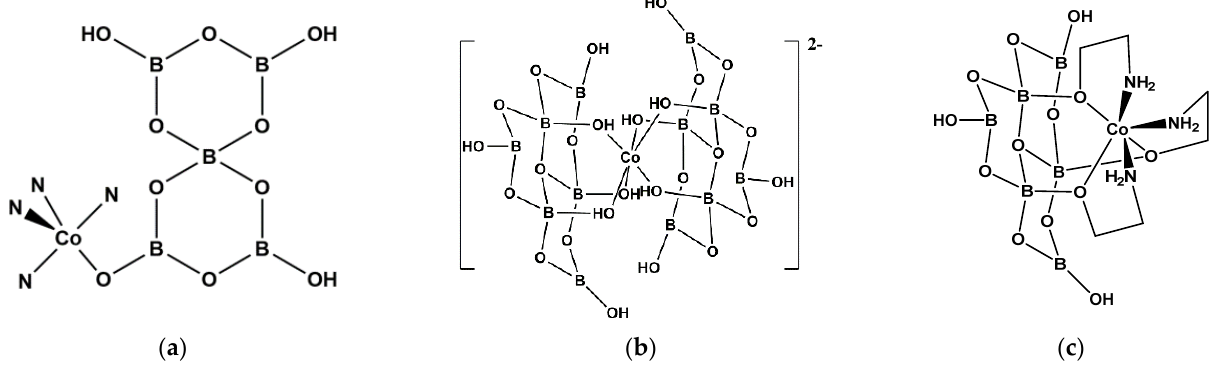
Figure 4. Drawings of ( a ) the uncharged unit of [Co(tren) {OB 5 O 6 (OH) 3 }] ( 9 ), ( b ) the dianion observed in [1-cyanopiperazinium][Co{B 6 O 7 (OH) 6 } 2 ] . 4H 2 O ( 11 ), and ( c ) the structure of [Co{(NH 2 CH 2 CH 2 O) 3 B 6 O 7 (OH) 3 }] ( 12 ).